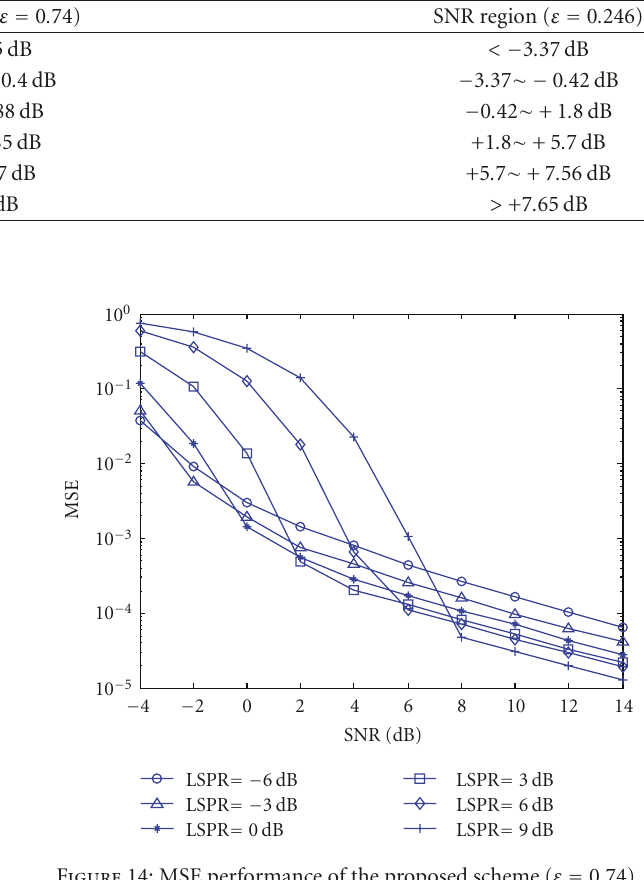
error is small or large value. Also there exists an optimum LSPR value according to SNR conditions.